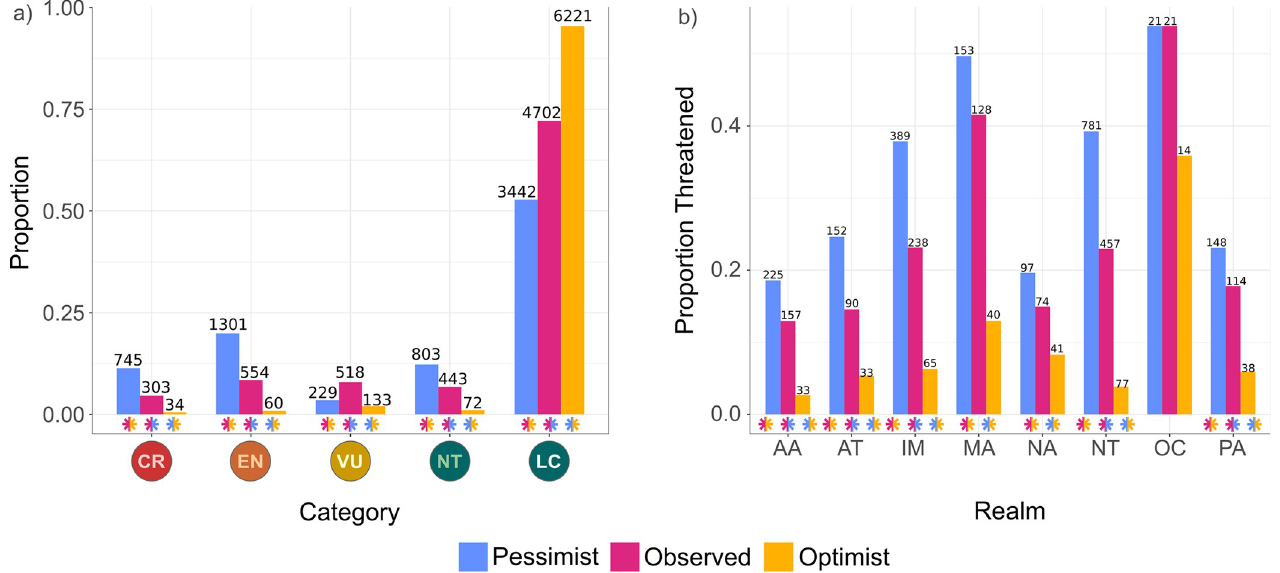
Fig 4. Proportion of threatened reptile species under different assessor bias scenarios. Analysis includes only species that have IUCN assessments (6,520 species). (a) Proportion of reptile species assigned to each extinction risk category for the actual IUCN assessments (Observed); proportion expected if the most optimistic group of assessors assessed every species (Optimistic); proportion expected if the most pessimistic group assessed every species (Pessimistic). (b) Proportion of threatened species in each biogeographical realm for Observed, Optimistic, and Pessimistic assessments. Significant differences in a Pearson’s χ 2 test are indicated by asterisks, colored according to which proportions are being compared (S11 Table). The data underlying this figure can be found in S2 Data. AA, Australasian; AT, Afrotropical; CR, Critically Endangered; EN, Endangered; IM, Indomalayan; LC, Least Concern; MA, Madagascan; NA, Nearctic; NT, Near Threatened; NT, Neotropical; OC, Oceanian; PA, Palearctic; VU,